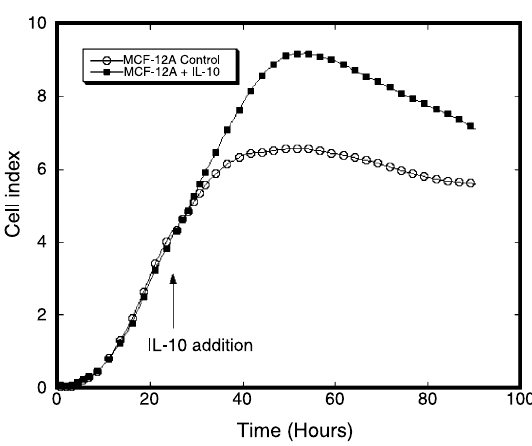
Fig. 2. MCF-12A human breast epithelial cell line given IL-10 24 hours after seeding in the E-Plate. The IL-10-treated cells show enhanced impedance compared to untreated cells beginning 6–8 hours after IL-10 addition and continuing for the duration of the experiment (65